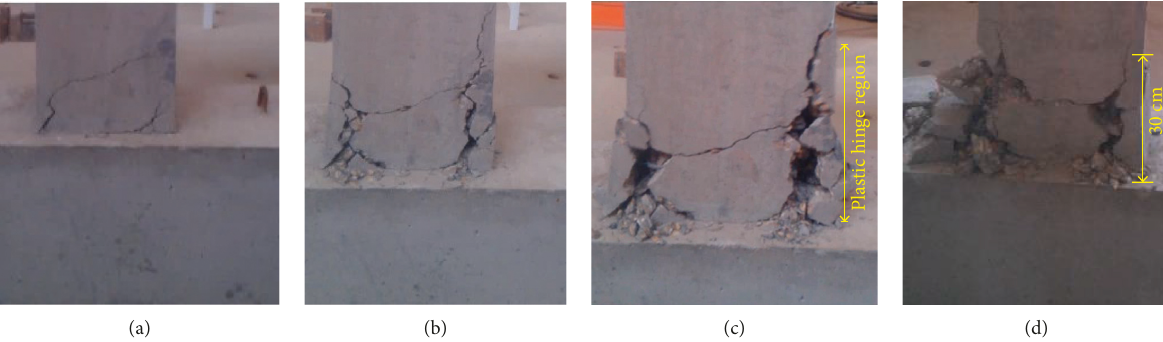
Figure 5: Damage of Z-2 at (a) 10th loading cycle; (b) 30th loading cycle; (c) 70th loading cycle; (d) 100th loading cycle.